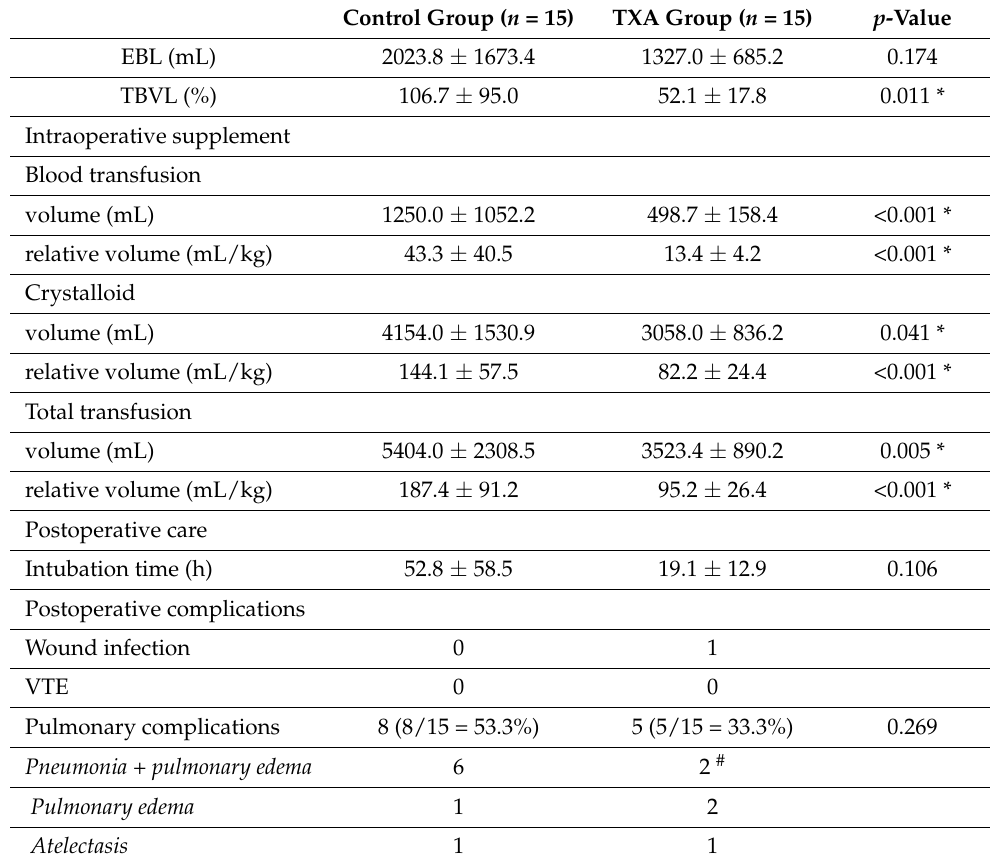
Table 2. Comparison of estimated blood loss, intraoperative infusion, and postoperative care between the Tranexamic acid group and control